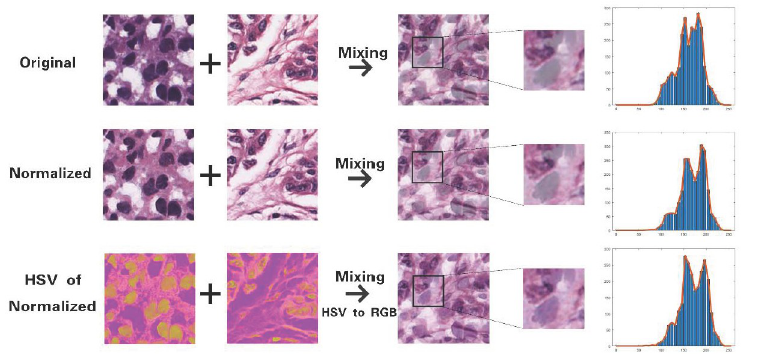
Fig 3. Comparison between mixing based on RGB and HSV